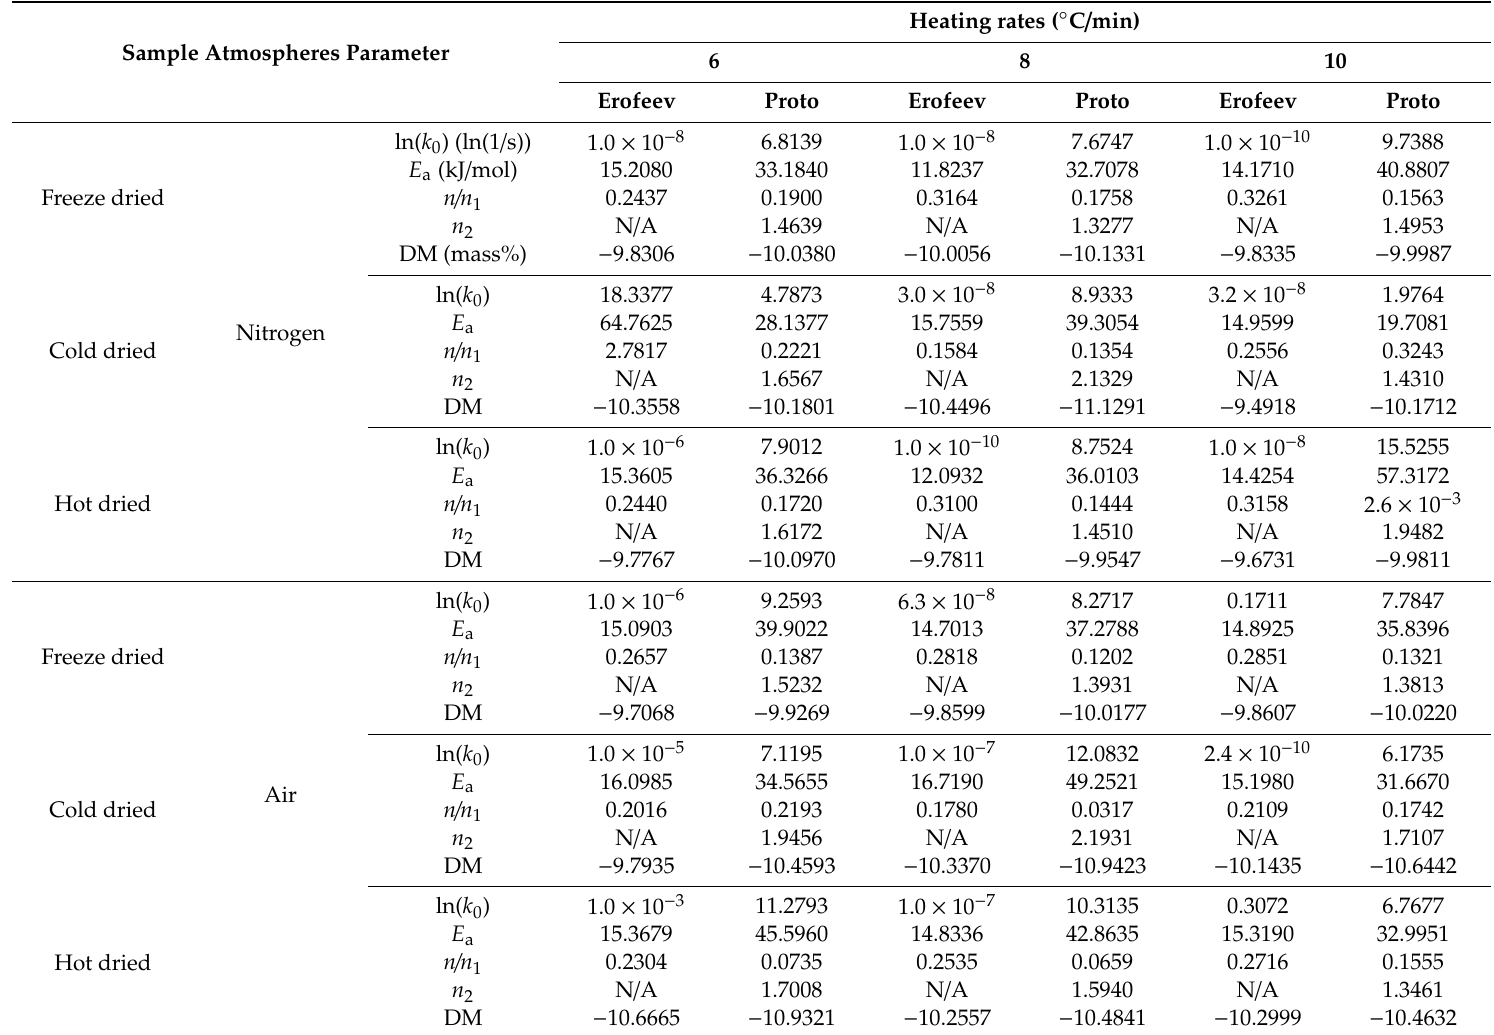
Table 6. Adsorption kinetic simulation results of thermogravimetry (TGA) (under nitrogen and air atmospheres) analyses for various drying processes.